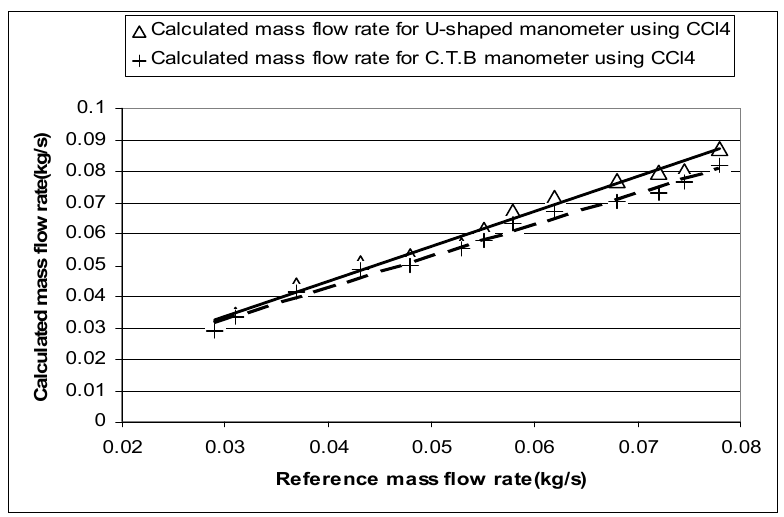
Figure 7. Comparison between reference and calculated mass flow rates in case of orifice meter using CCl